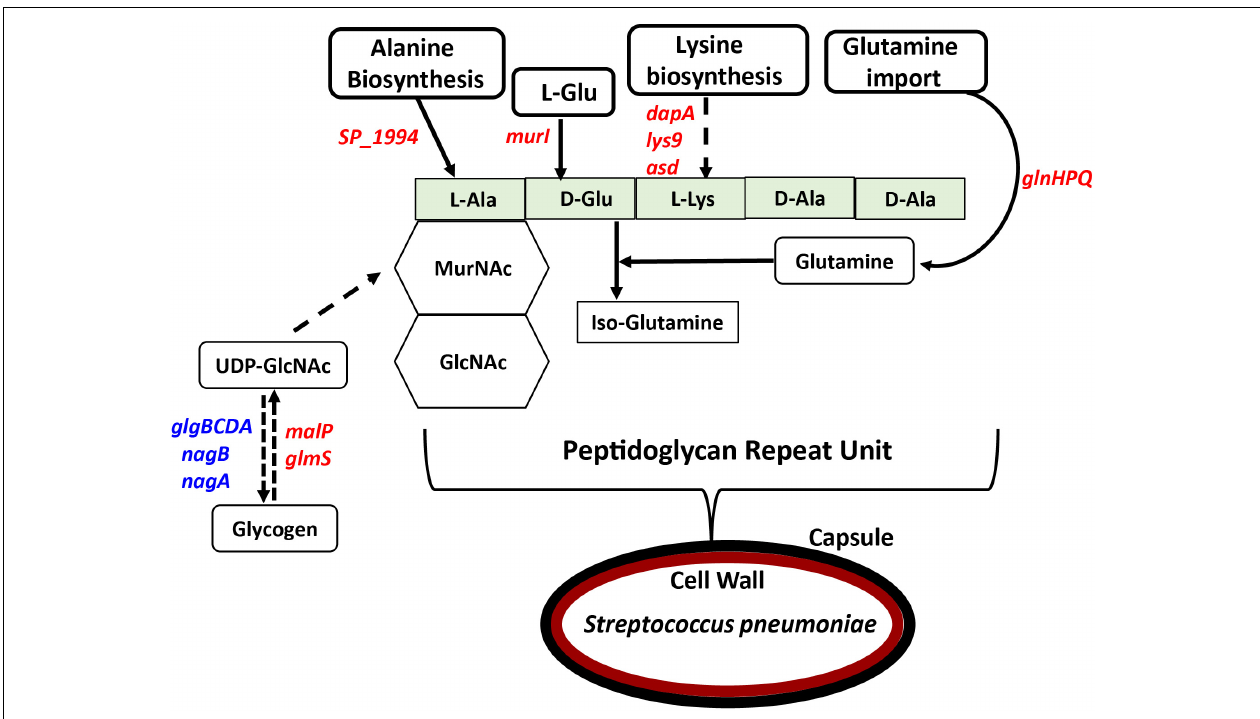
FIGURE 2 | Impact of impaired polyamine synthesis on PG biosynthesis. The PG repeat unit structure in pneumococci constitutes a disaccharide (hexagon) composed of GlcNAc and MurNAc that is linked to an L -Ala, D -Glu, L -Lys, D -Ala, and D -Ala pentapeptide (light green rectangle). RNA-Seq-based comparative transcriptome analysis of (cid:49) cadA impaired in polyamine synthesis and the wild type S. pneumoniae TIGR4 identified gene (italicized) expression changes (increase in blue and decrease in red) that could impact the PG repeat unit synthesis and cross-linking. Enzymatic reactions are shown as black arrows and multi-step reactions are represented by a broken arrow. Reduced synthesis of UDP-GlcNAc due to reduced expression of malP and glmS , and its increased breakdown due to higher expression of nagA , nagB , and the glgBCDA operon, will impact PG synthesis. Reduced expression of SP_1994 that converts pyruvate to alanine, murI that converts L -Glu to D -Glu, and lysine biosynthesis genes ( dapA , lys9 , and asd ) will limit the availability of these three amino acids in PG pentapeptide synthesis. Crosslinking of the PG repeat unit requires conversion of D -Glu to iso-glutamine using glutamine as a co-factor. Impaired glutamine import, due to reduced expression of glnHPQ was observed in (cid:49) cadA. The overall impact of polyamine synthesis impairment is altered cell wall biosynthesis (red oval), due to specific effects on PG synthesis. The cell wall provides the point of structural attachment for the capsule (black oval) in S. pneumoniae .